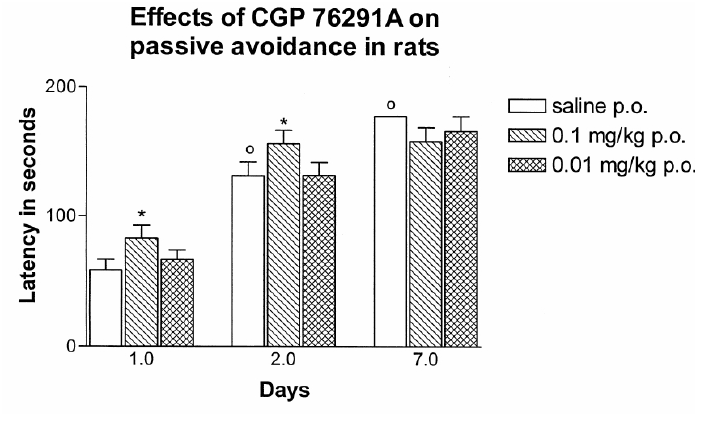
Fig. 5 Effects of GABA B receptor antagonist CGP76291A on learning and memory re- tention in rats on passive avoidance test. Abscissa - days of testing; Ordinate - latency(s). o P < 0 . 05 compared to the 1 st day control. ∗ P < 0 . 05 and ∗∗ P < 0 . 01 compared to the respective